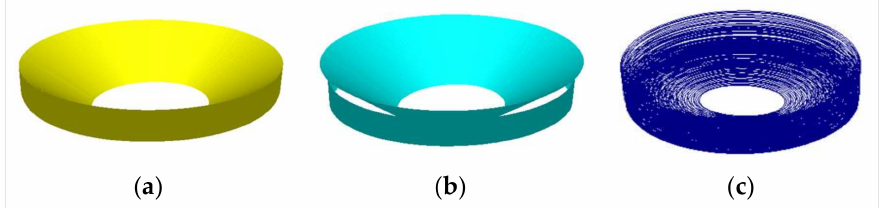
Figure 21. The second-stage forming toolpath: ( a ) the surface of forming area; ( b ) the tool location surface; ( c ) the generated forming